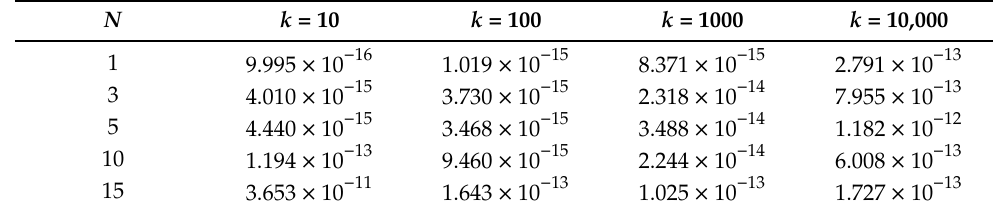
Table 1. The absolute error for B n ( x , k ) .